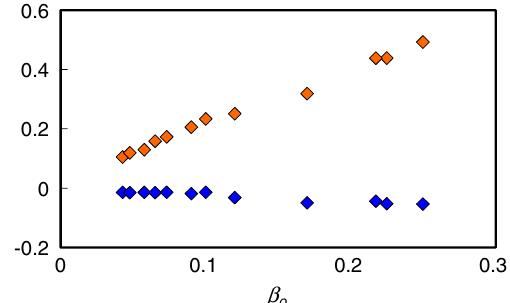
FIG. 2. Relative strength (on axis) of the average transverse electric and magnetic field components in a gap, normalized to the accelerating one (see definition in the text), E =E and cB (red), as a function of the QWR optimum (cid:1) , xo zo calculated for 12 coaxial QWRs of the INFN-TRIUMF type.